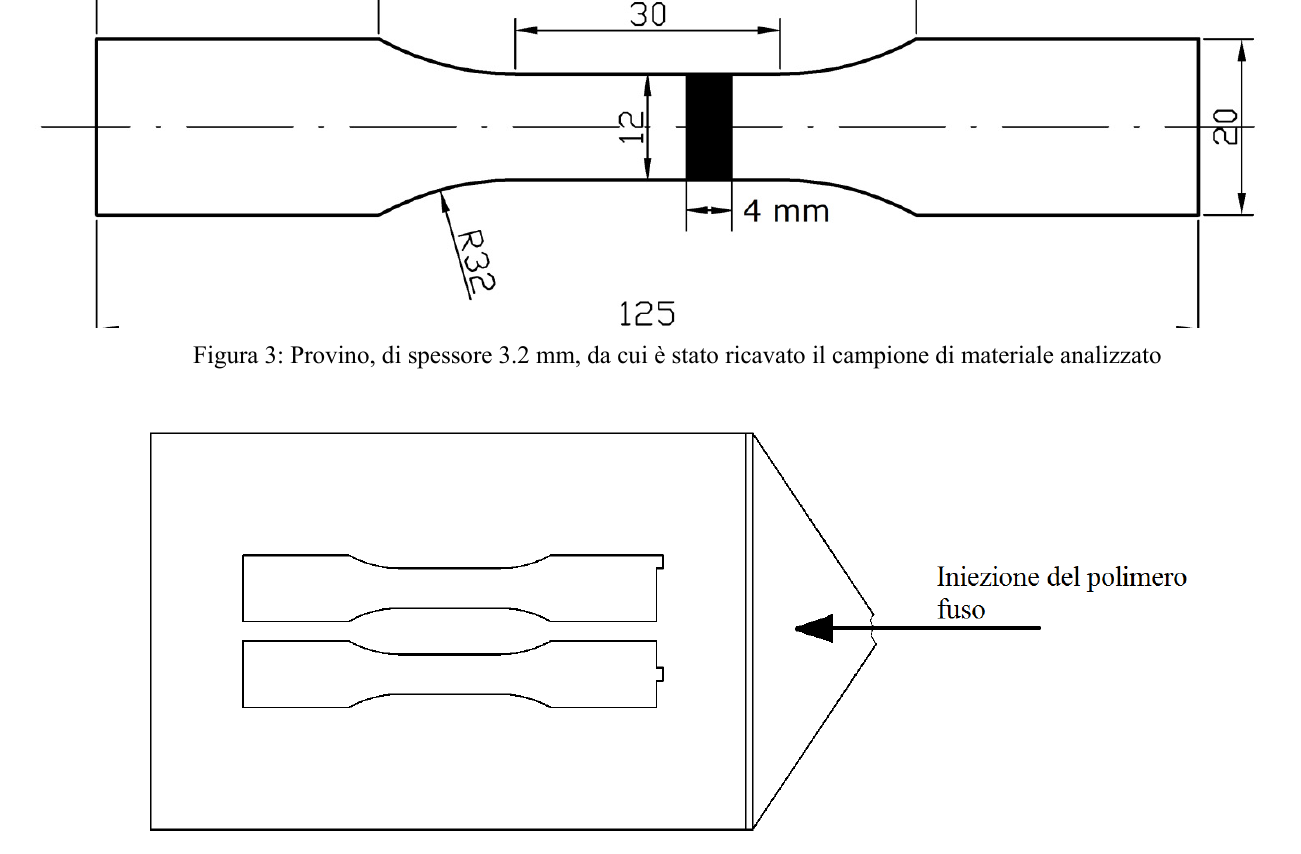
Figura 4: Lastra da cui è stato estratto il